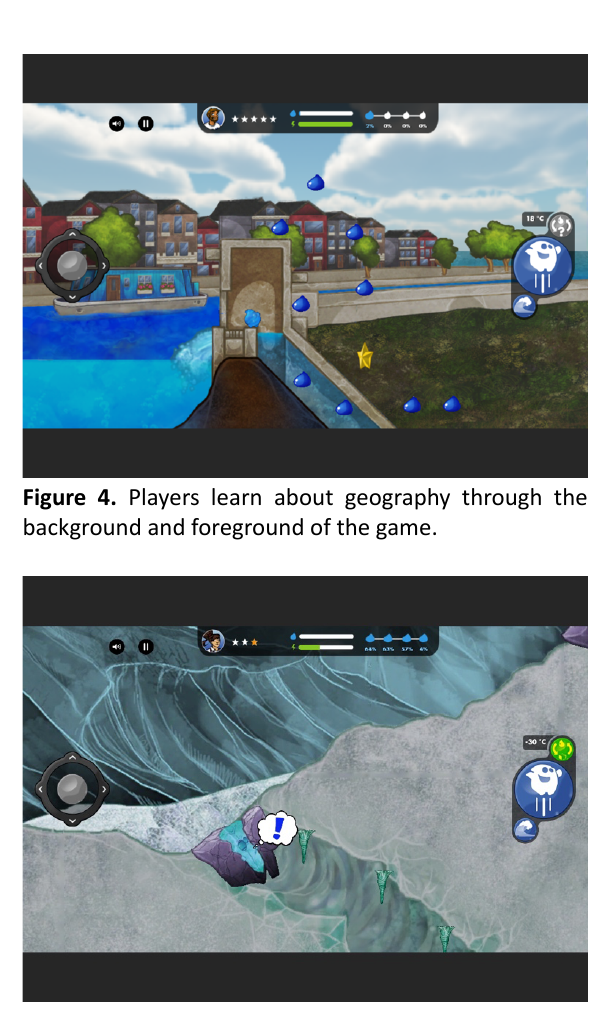
Figure 5. Sprite changes form from a water droplet to a piece of ice.